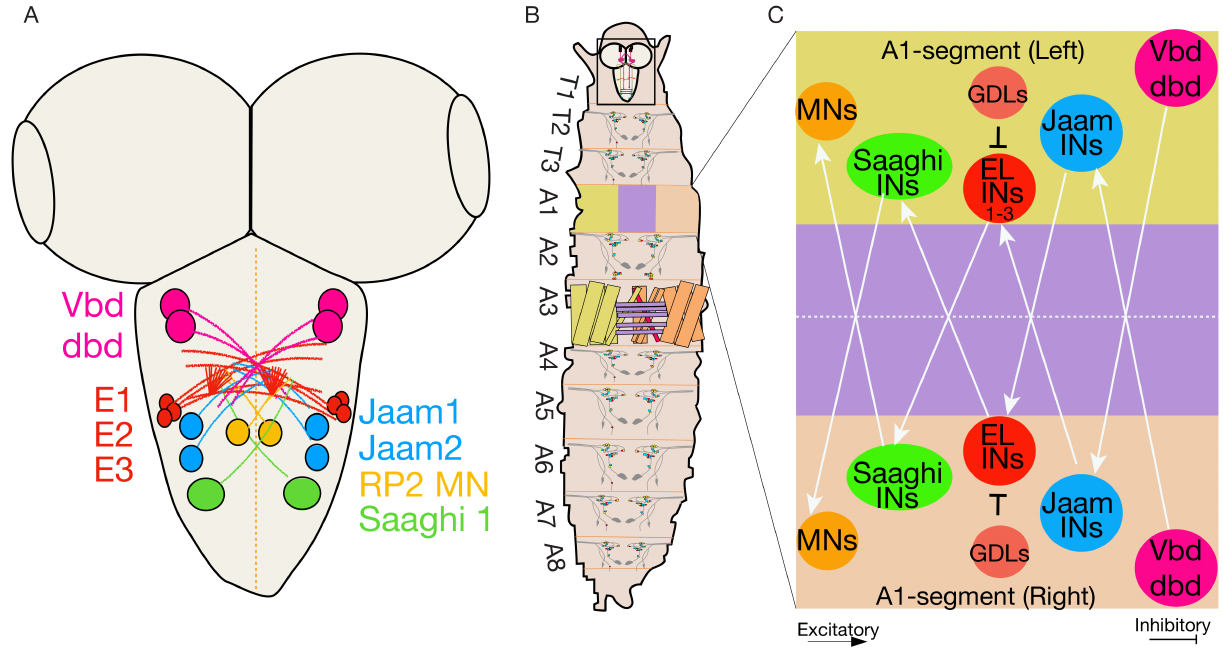
Figure 4. Neural circuits are involved in bilateral motor coordination. ( A ) A schematic showing the anatomical location of cell bodies of neurons involved in bilateral motor coordination (adapted and modified from [50]). ( B ) A schematic showing a top view of larval body segments. The red/blue/green territories in the abdominal segment A1 represent muscle groups in each segment. Red represents dorsal LMs, blue represents TMs, and green represents ventral LMs. Sensory nerves in A2 abdominal segments and MNs output to muscles (colored diamond, circles, and squares). ( C ) The EL (Eve positive lateral) interneuron sends bilateral connections to Jaam interneurons, Saaghi interneurons and MNs (RP2-output neurons), receives inputs from proprioceptive sensory neurons (Vbd and dbd) and controls bilateral motor coordination. The ELs also receive inhibitory input from GABAergic GDL interneurons (adapted and modified from